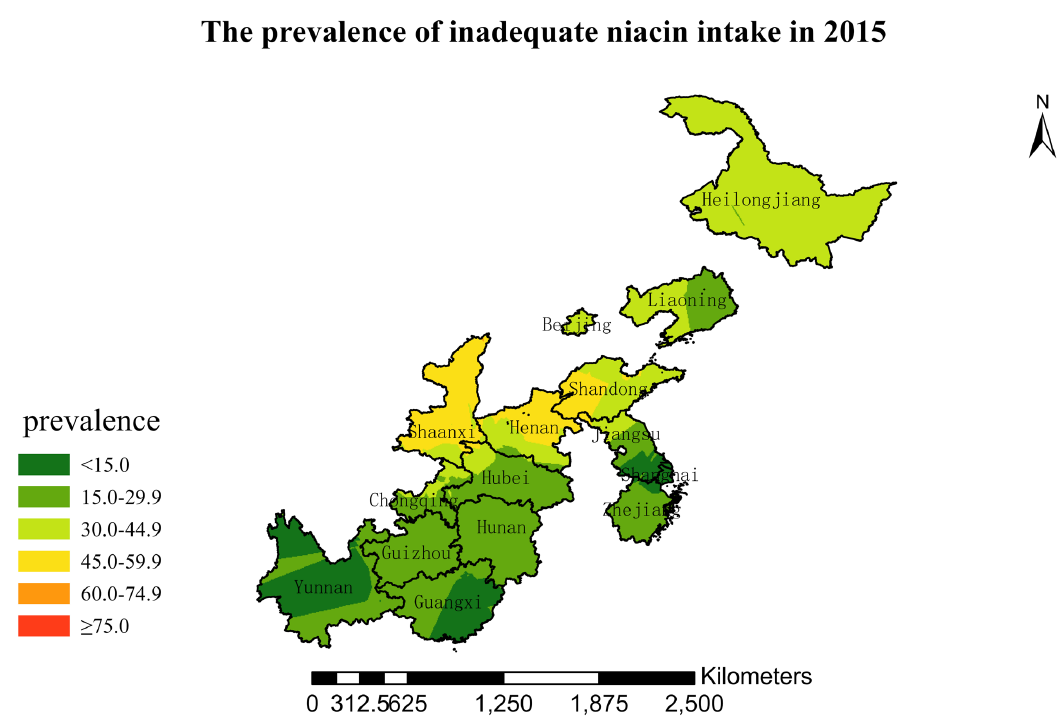
Figure 9. The prevalence of inadequate niacin intake by county in 2015 among Chinese Residents ≥ 5 Years of Age.